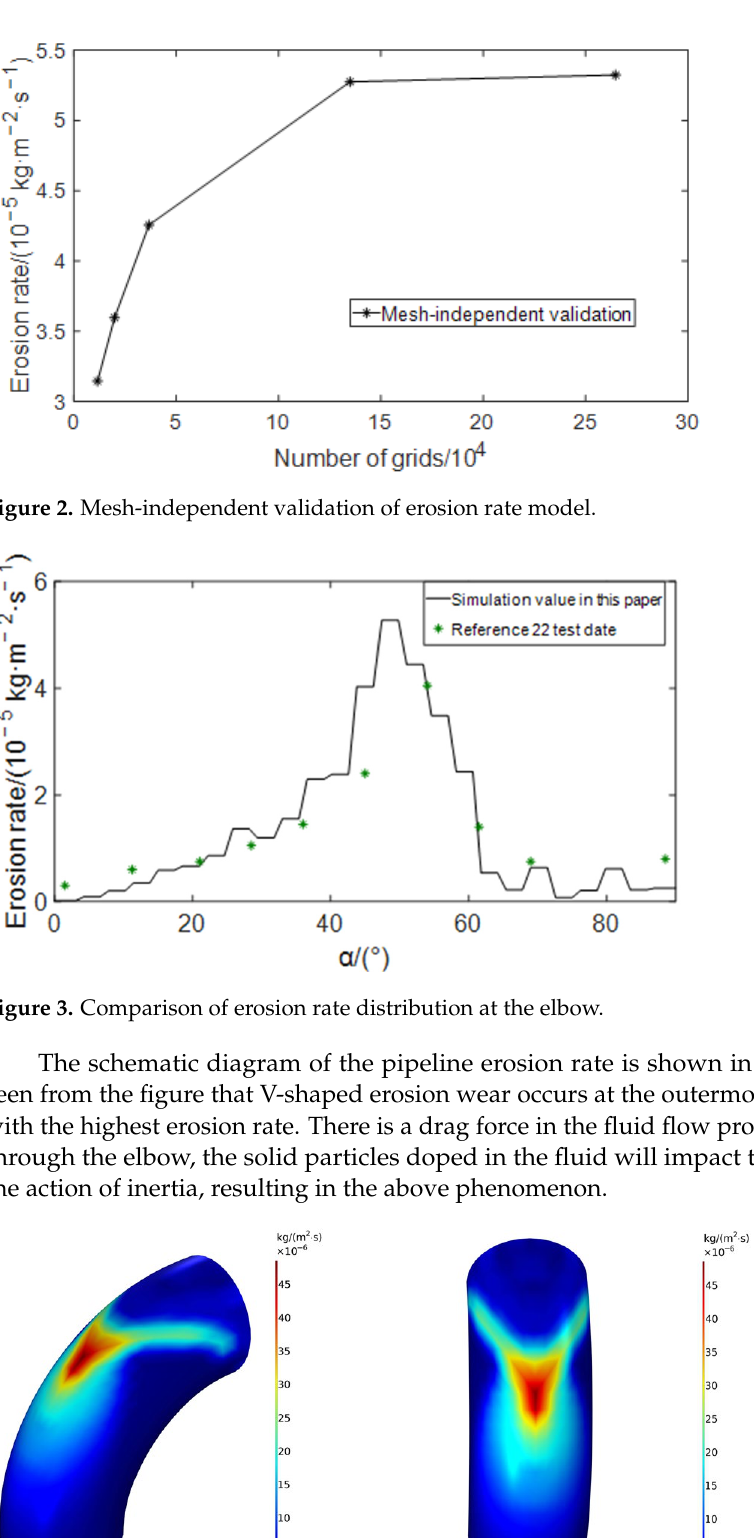
Figure 4. Schematic diagram of erosion rate distribution at elbows. ( a ) Side view; ( b ) Front view.